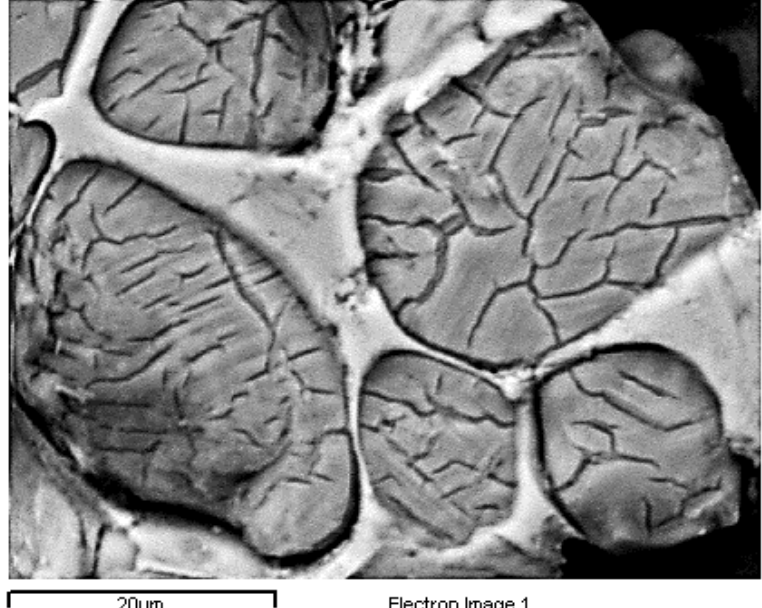
Figure 14. Belite crystals with lamellas of P 71A_1450.